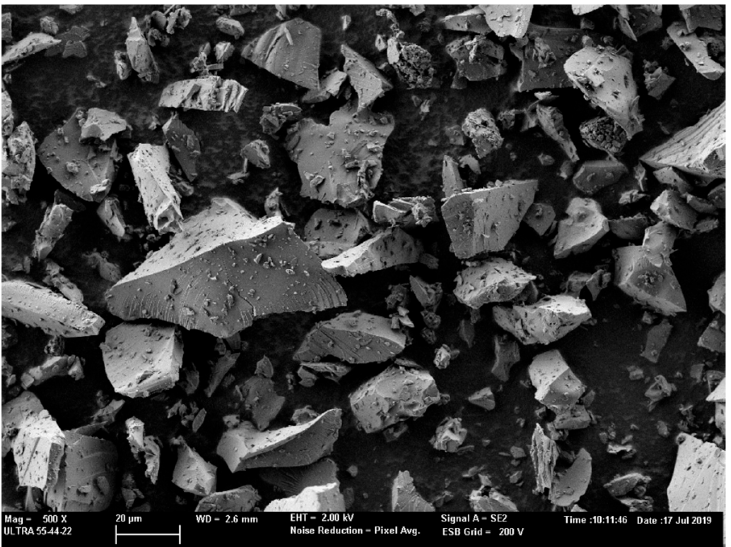
Figure 3. Shape and size of the GP particles seen by FESEM at 500× magnification .